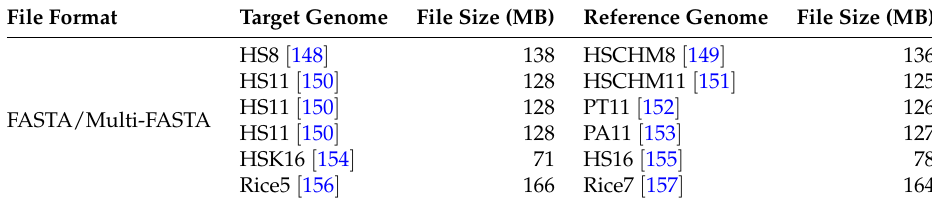
Table 2. Genomic sequence datasets used by reference-based compression